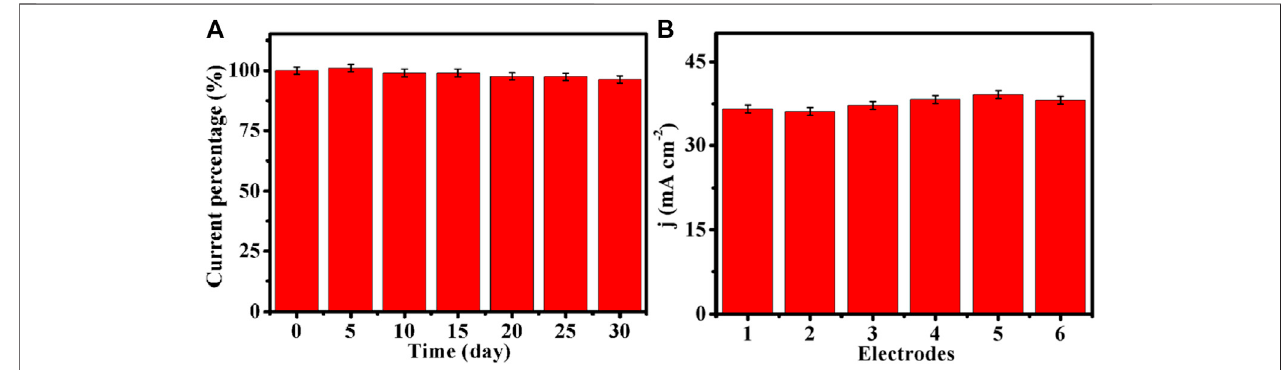
FIGURE 6 | (A) Stability of Cu-MOF/CF to 1 mM glucose tested every 7 days by cyclic voltammetry in 1 month. (B) Reproducibility of six biosensors toward 1 mM glucose in 0.1 M NaOH.